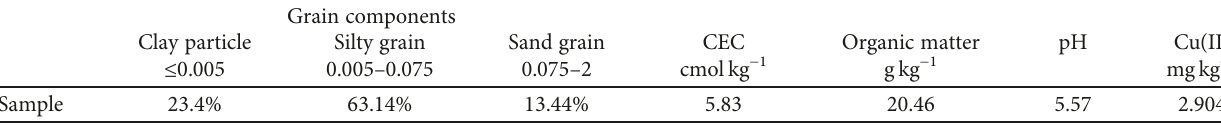
Table 1: Physical and chemical properties of the tested soil.